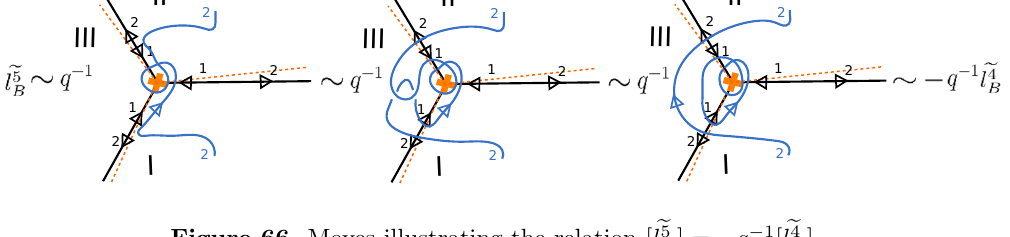
Figure 66 . Moves illustrating the relation [ e l 5